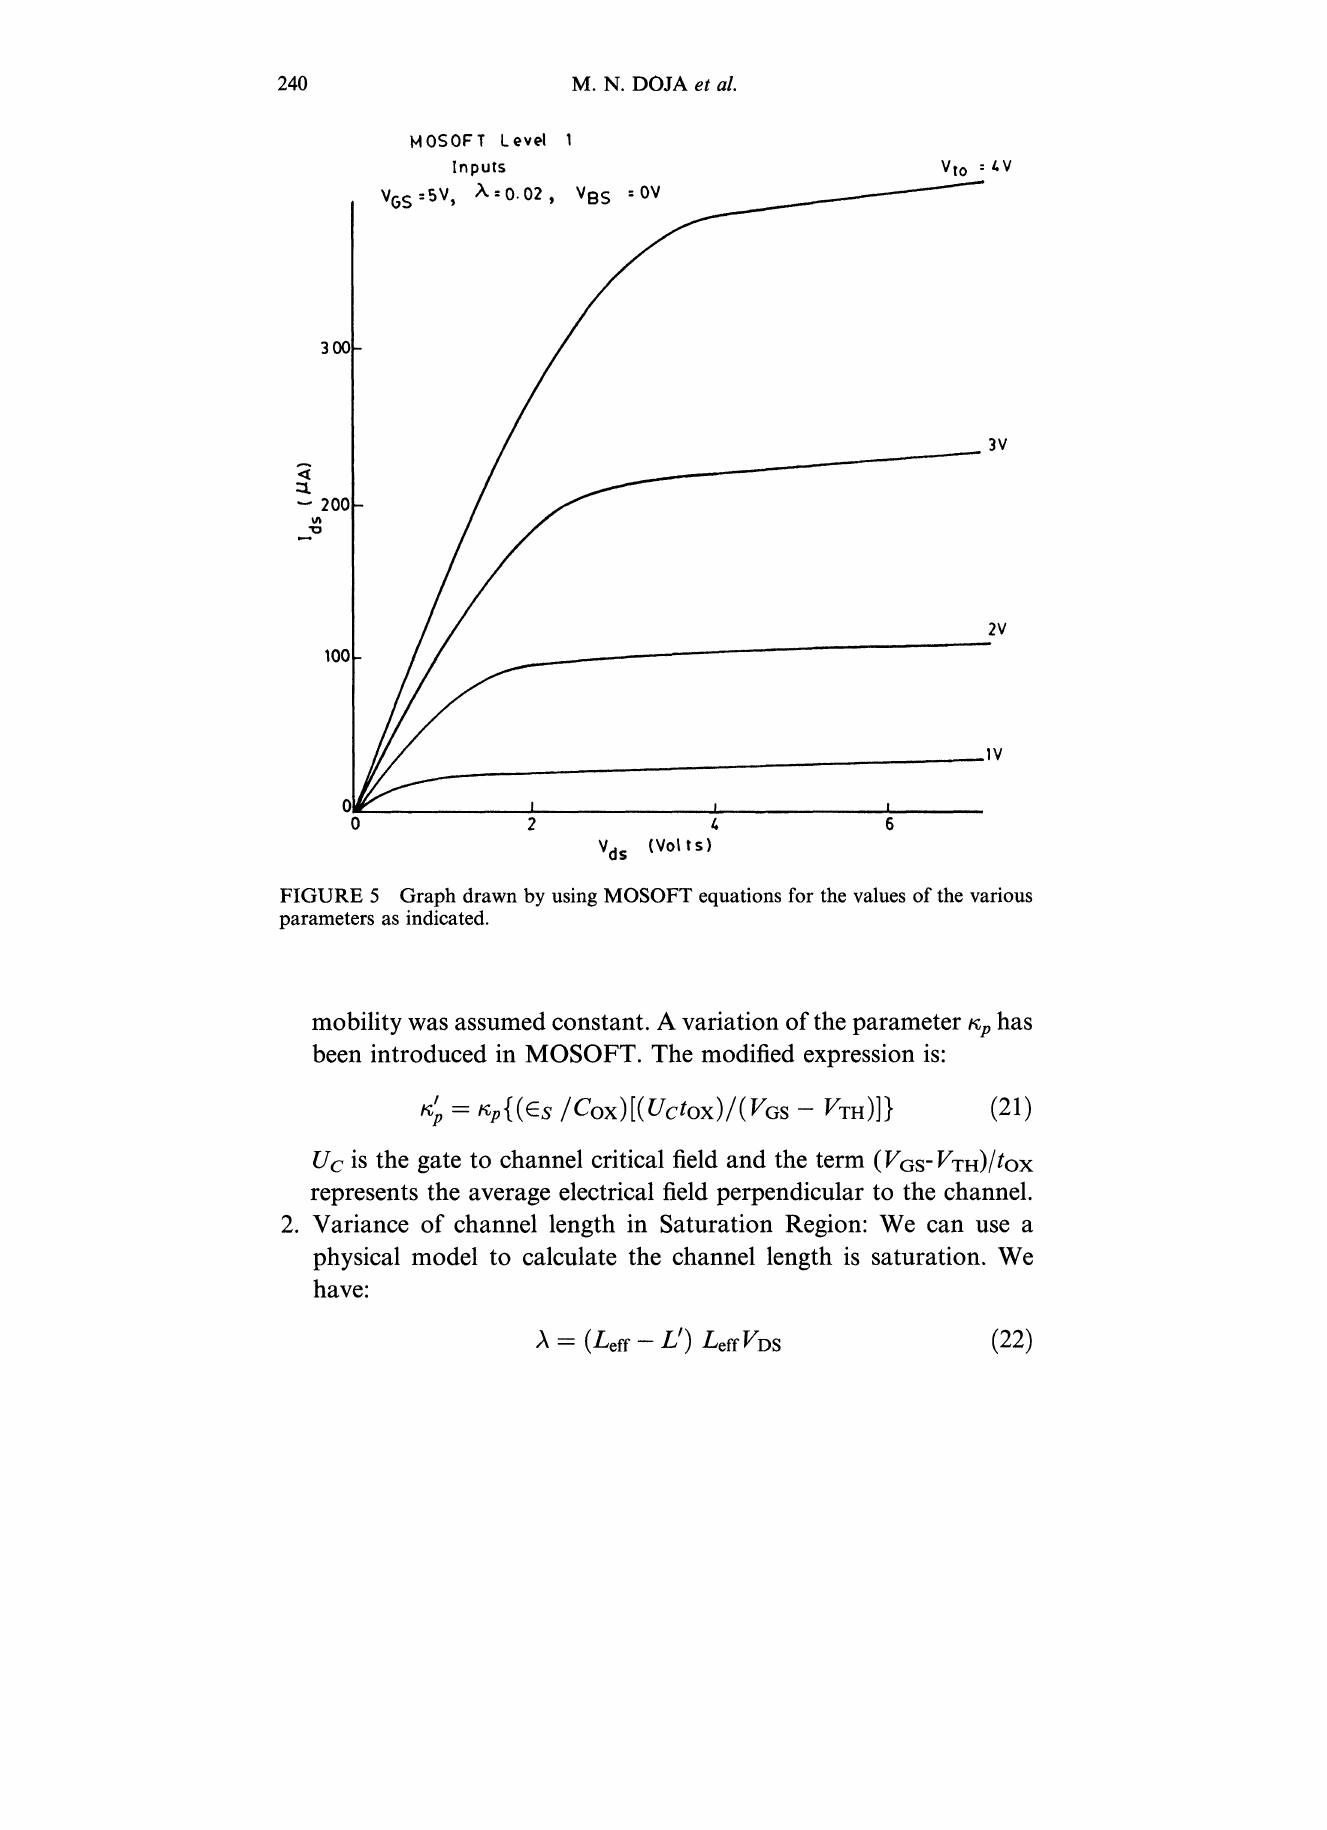
FIGURE 5 Graph drawn by using MOSOFT equations for the values of the various parameters as